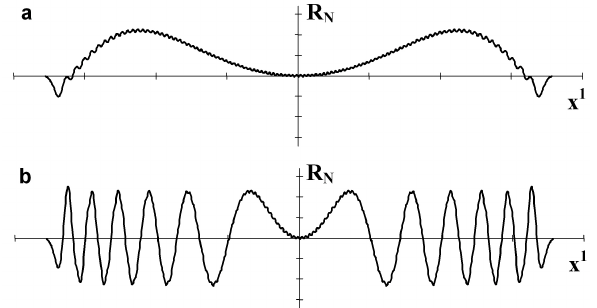
Fig. 4. Structure of the wave field across magnetic shells: (a) for t =1000s (10 periods approximately) after the impulse, (b) for t = 10000 s ( ∼ 100 periods) after the impulse.